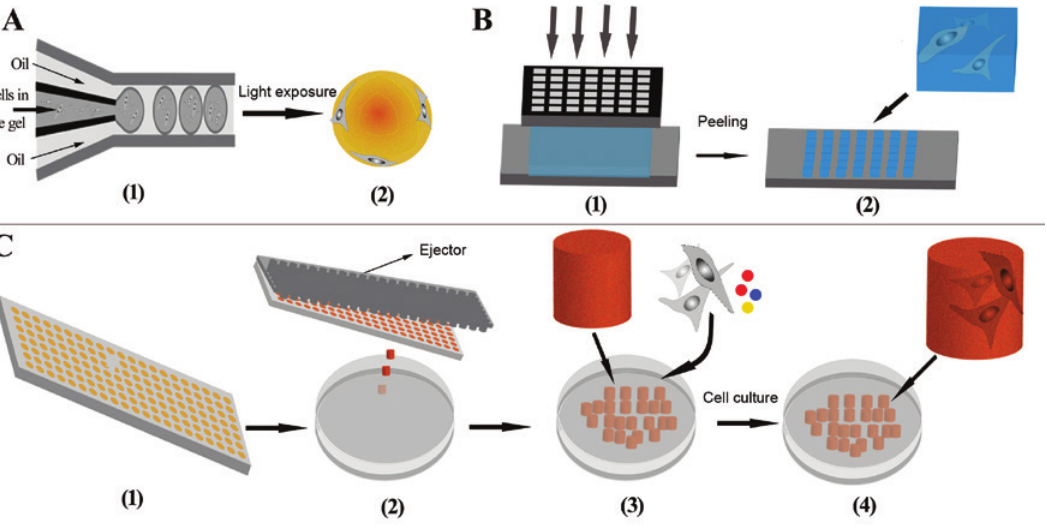
Figure 3: Schematic diagram of microcarrier fabrication method. A. Droplet-based microfluidics method. (1) Schematic diagram of the microfluidic flow-focusing device. (2) The harvested microsphere. B. Photolithography methods. (1) A photomask with designed holes, which light passes to trigger polymerization. (2) After peeling, the harvested microgels. C. Mold method (see the description in Section